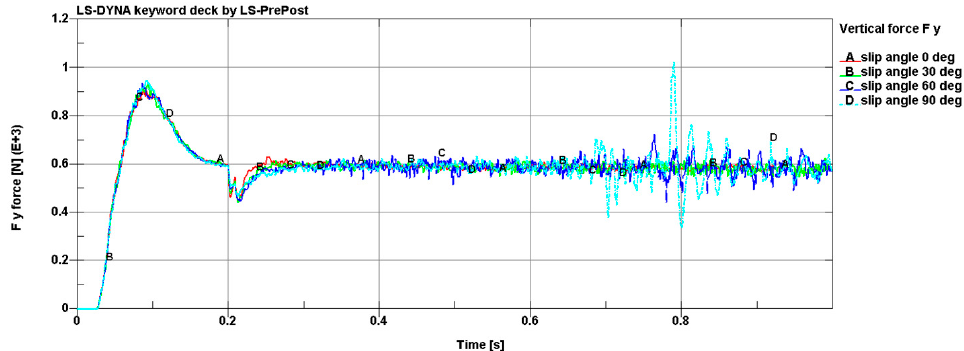
Figure 16. The distribution of the vertical force as a function of time for the range of slip angles.